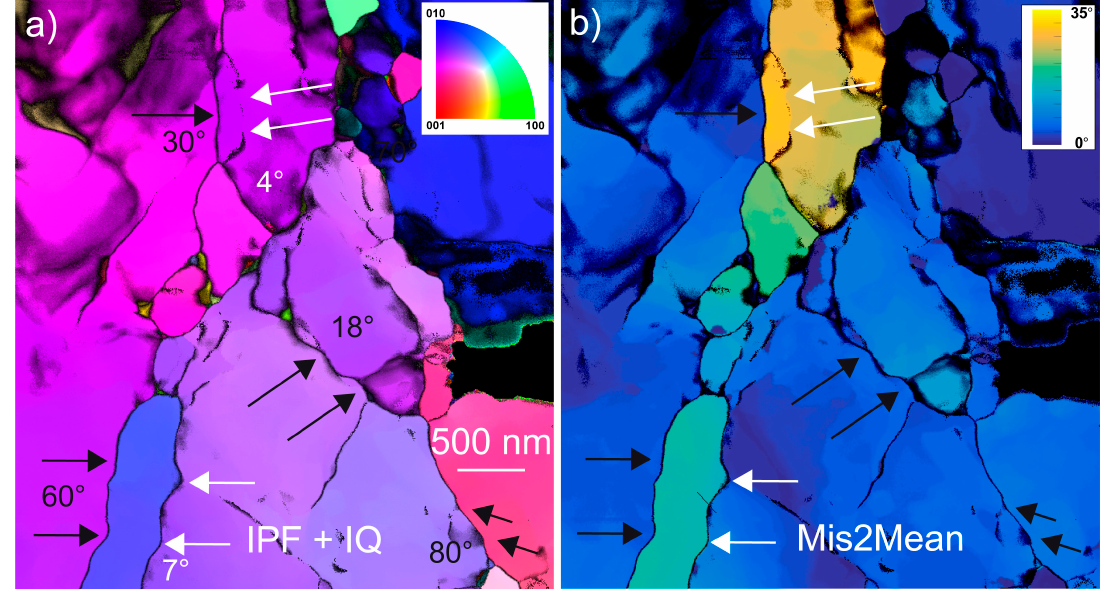
Figure 7. For70B GB (arrows in black), SGB (arrows in white), and small grains. ( a ) IPF corresponding to the direction perpendicular to the plane of view superimposed with the IQ (Equation (1)); color code inserted ( Pnma ). The misorientation of some boundaries are indicated next to them. ( b ) Mis2Mean map corresponding to ( a ), up to 35°.